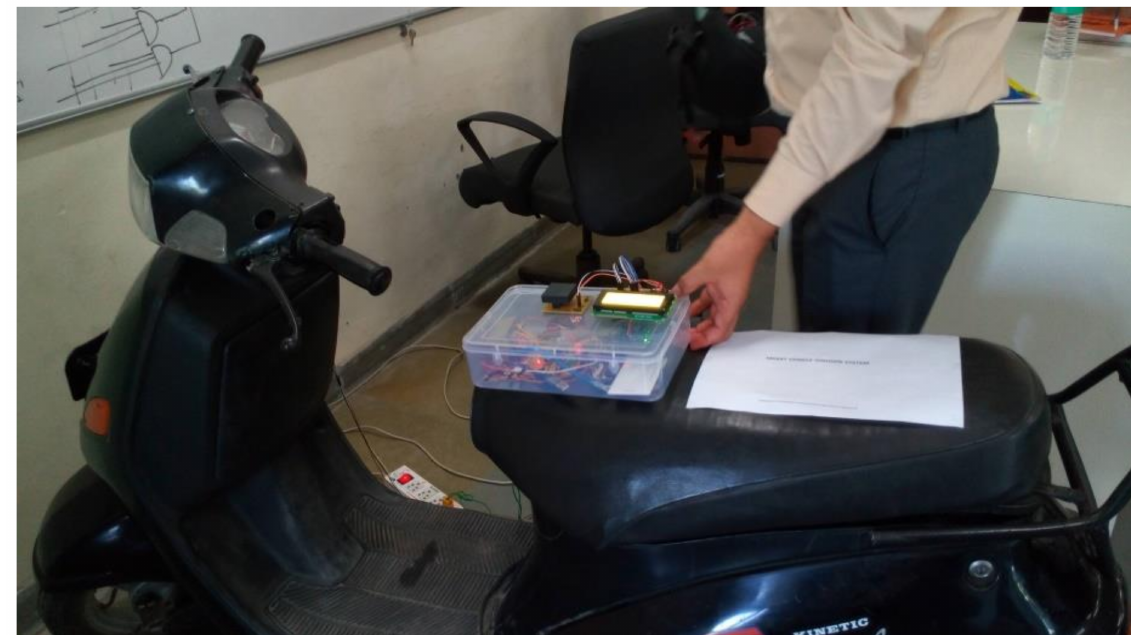
Figure 15. Hardware embedded to